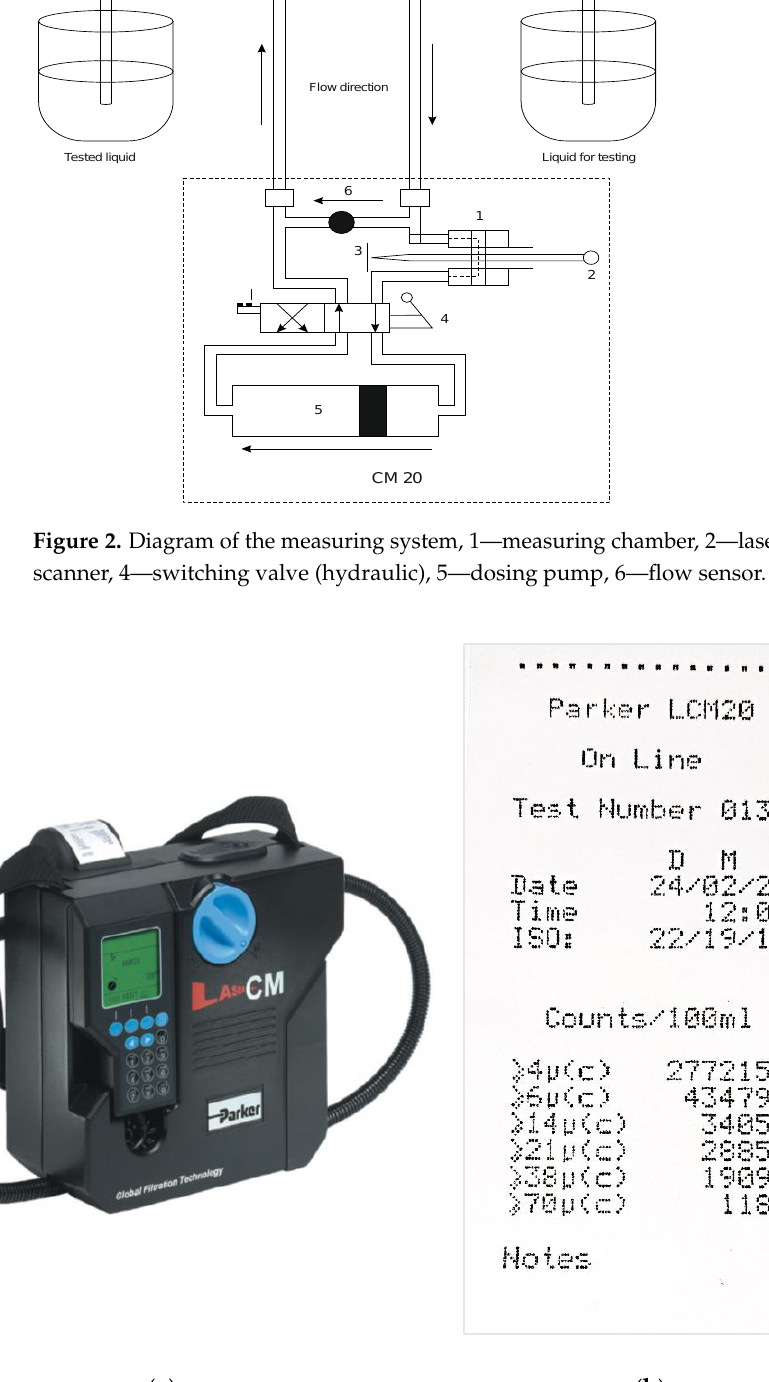
Figure 2. Diagram of the measuring system, 1—measuring chamber, 2—laser light source, 3—opti- cal scanner, 4—switching valve (hydraulic), 5—dosing pump, 6—flow sensor.